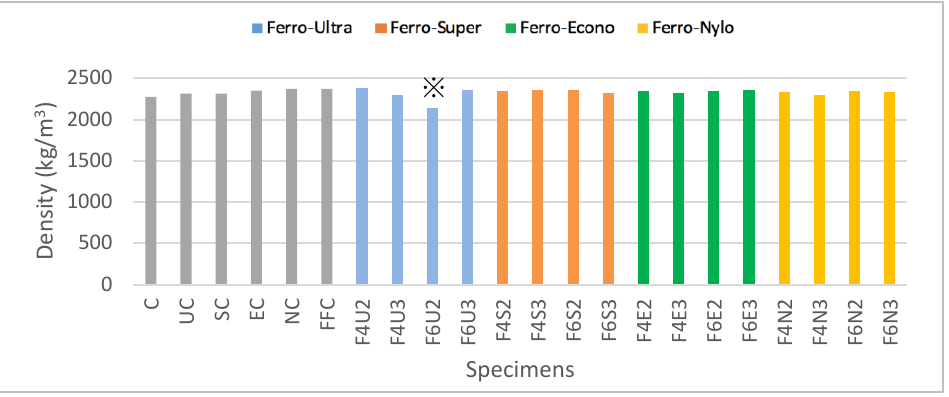
Figure 3. HyFRC densities. ( ※ = irregular density).